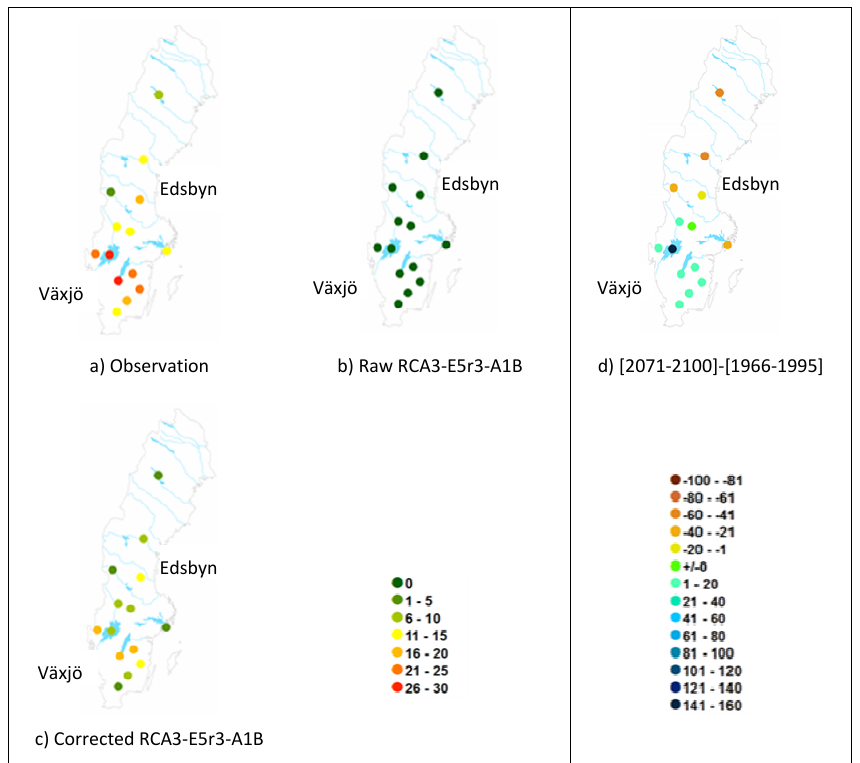
Figure 11. Number of days with high fire risk (FWIX > = 5) during the calibration period (1966–1995) presented by (a) observation, (b) raw RCA3-E5r3-A1B and (c) corrected raw RCA3-E5r3-A1B; and changes of number of days with high fire risk (FWIX > = 5) in percentage during the period of (d)